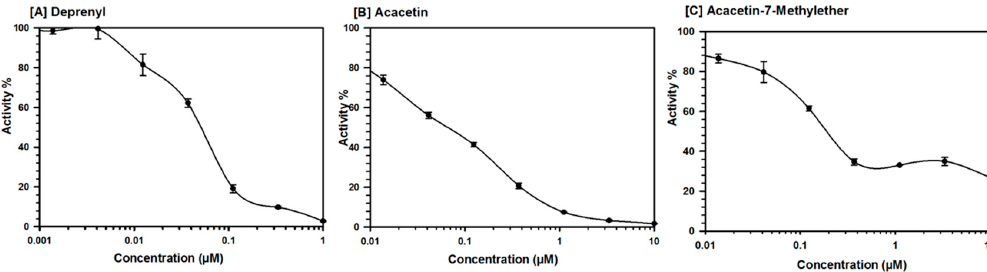
* The IC 50 values, computed from the dose response inhibition curves, are mean ± S.D. of at least triplicate observations. SI—Selectivity Index-IC 50 MAO-A/IC 50 MAO-B inhibition. # Safinamide data from ref. [18].